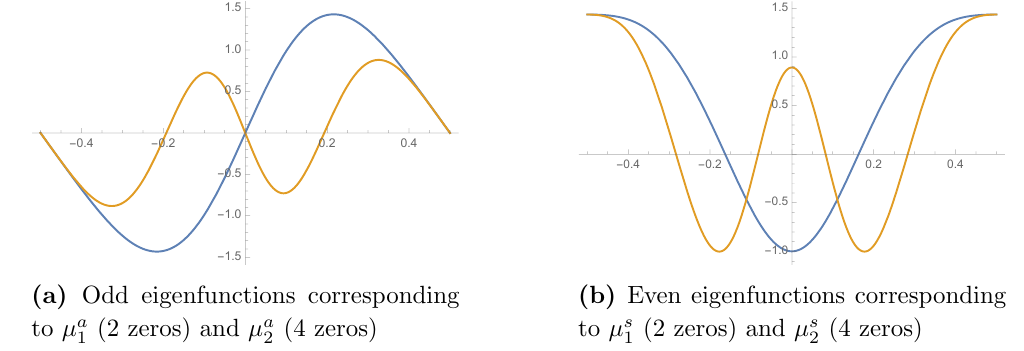
Figure 4. Odd and even eigenfunctions corresponding to the eigenvalues of table